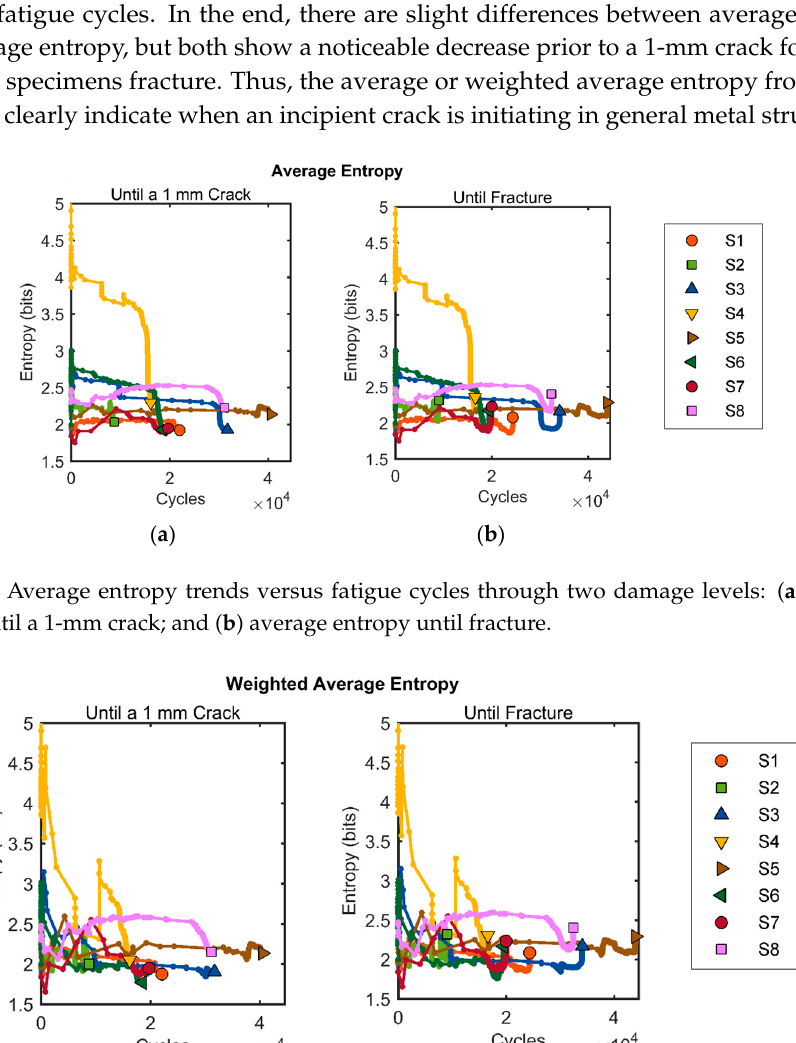
( b ) Figure 12. Weighted average entropy trends versus fatigue cycles and hit count over the first 500 cycles: ( a ) weighted average entropy versus cycles; and ( b ) weighted average entropy versus hits. The average and weighted average entropies are then plotted against cycles until both a measured 1-mm crack and fracture occur in Figures 13 and 14. As seen in this figure, sporadic AE signals are received for the majority of life as dislocation pileups and breakaways occur at multiple potential crack initiation sources. After a crack initiates and continues to grow to 1 mm, a common transition